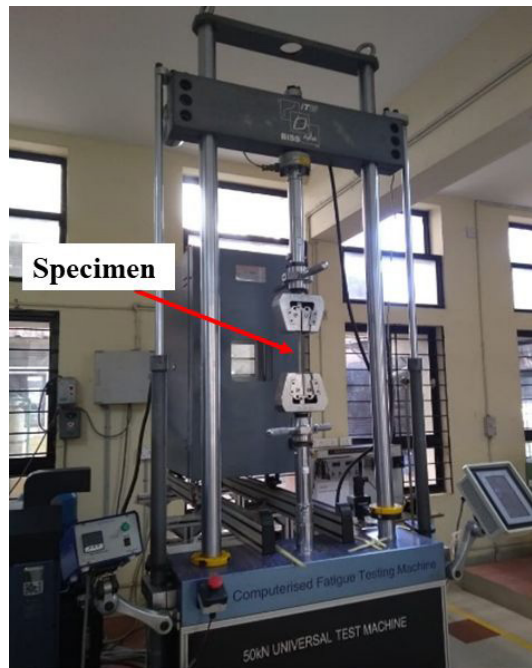
Figure 2. Tensile test